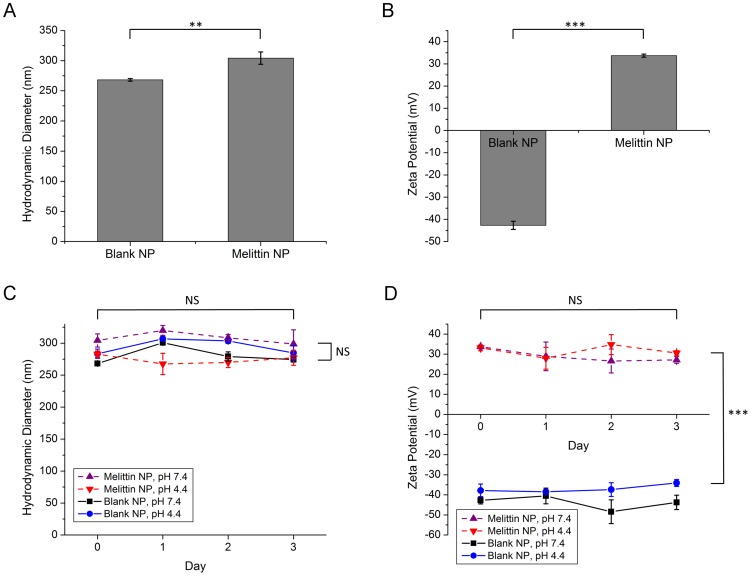
Physicochemical properties and stability of blank NPs and mel-NPs.(A and B) Size and zeta potential of blank NPs and mel-NPs immediately following preparation. (C and D) Size and zeta potential of blank NPs and mel-NPs following incubation for up to 3 days at pH 7.4 or pH 4.4. Error bars represent S.D. of n = 3 replicates, NS p>0.05, ** p<0.01, *** p<0.001.